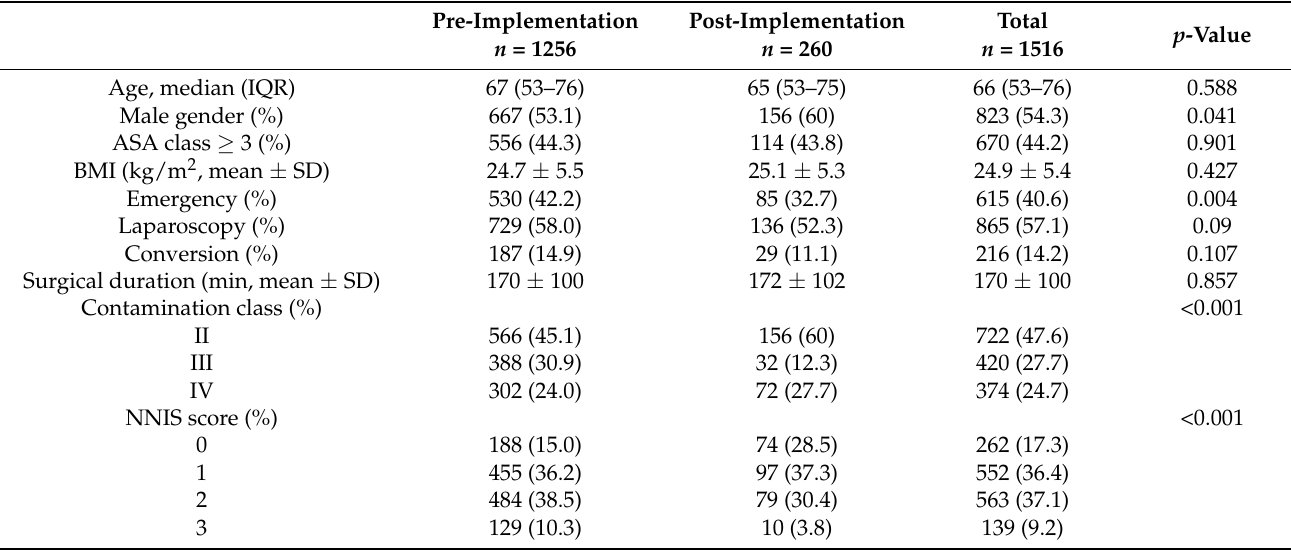
Table 1. Demographic characteristics and surgical details.